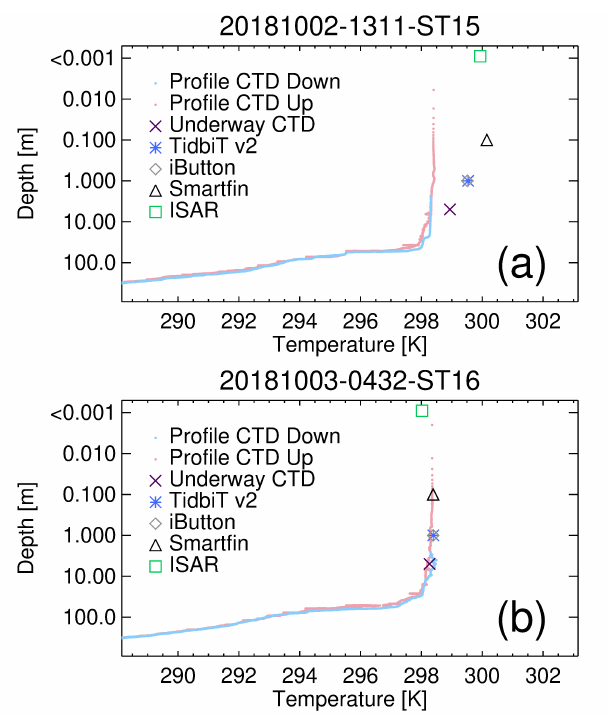
Figure 5. Near-surface temperature gradients determined from combining data collected on the Atlantic Meridional Transect cruise 28 from the ISAR, the Simple Oceanographic floating Device (SOD, Smartfin, iButton and TidbiT v2), underway CTD and profiling CTD. ( a ) Data from Station 15 and ( b ) data from Station 16 (titles are YearMonthDay-HourMinute–StationNumber, where Hour and Minute refer to the start time of the SOD